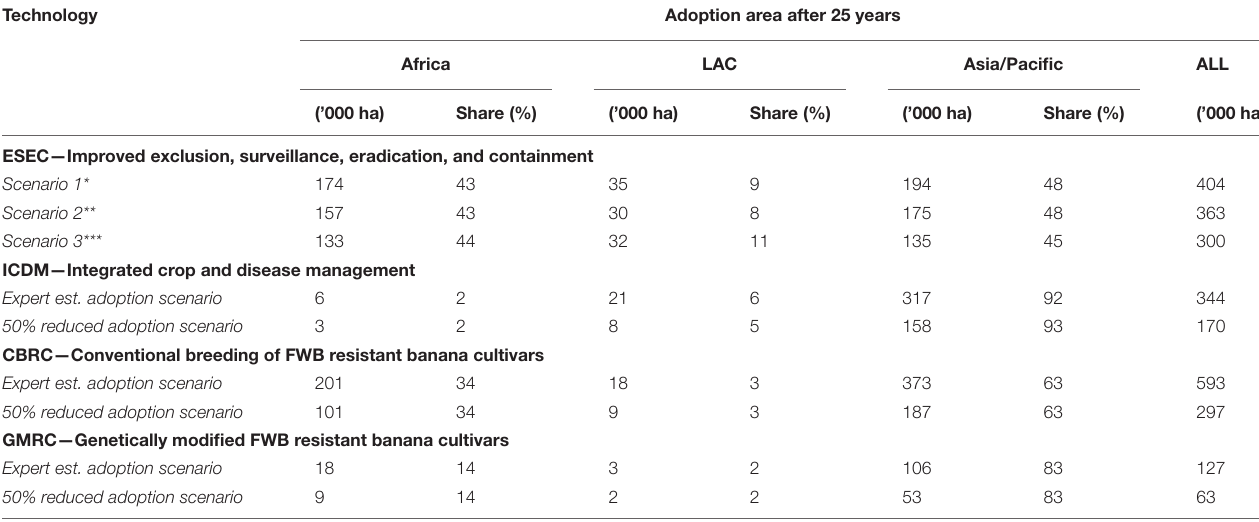
TABLE 6 | Results—regional breakdown of adoption area. Technology